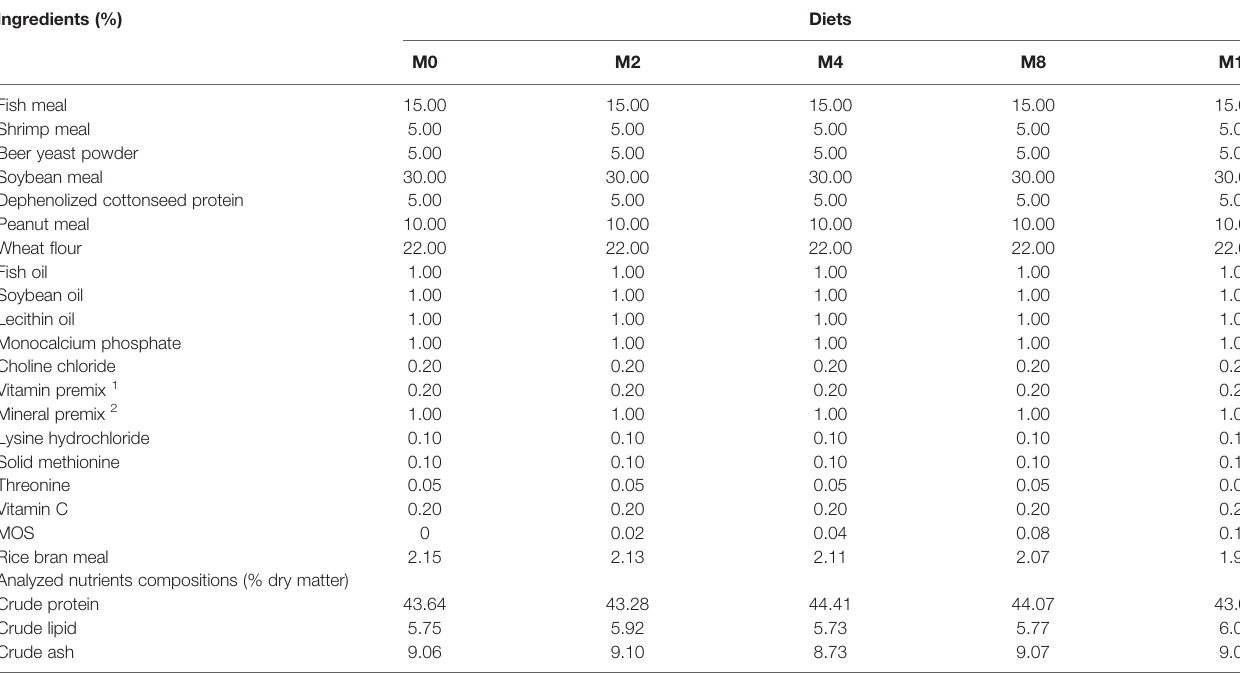
TABLE 1 | Formulation and proximate composition of the experimental diets (% dry matter). Ingredients